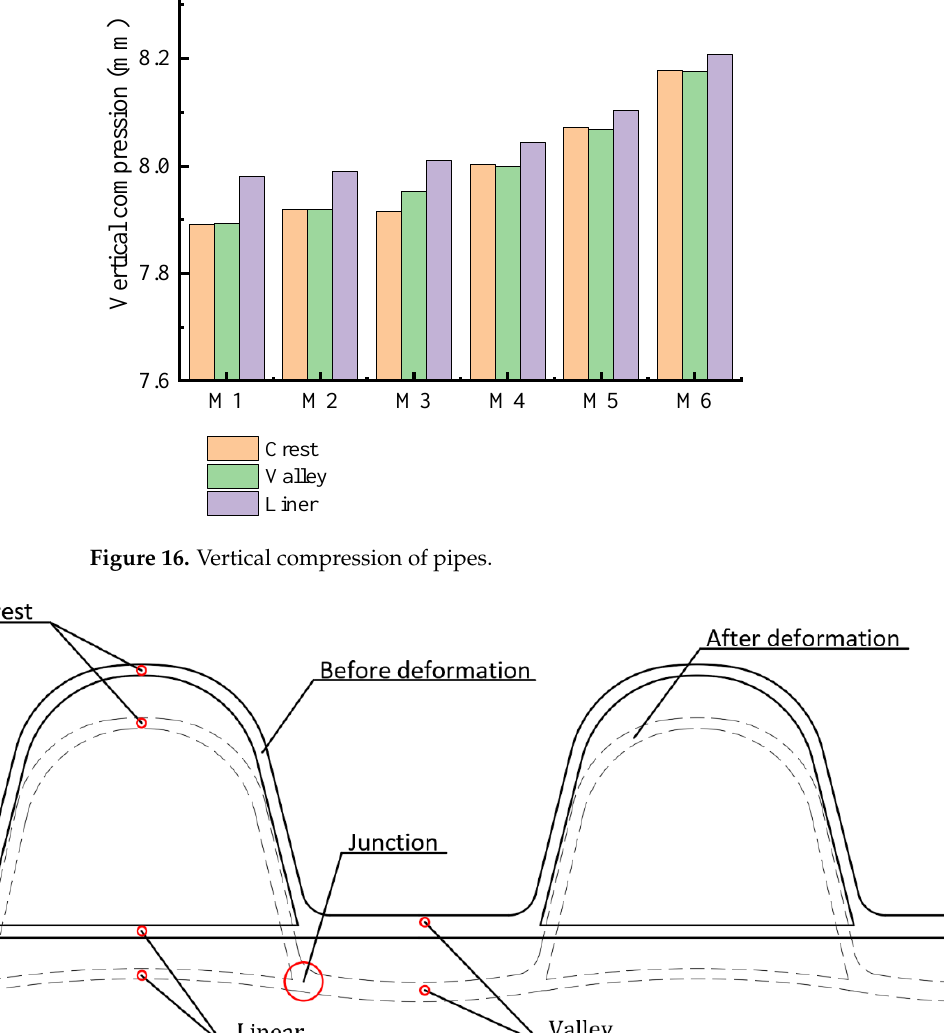
Figure 17. Schematic diagram of cross section deformation.